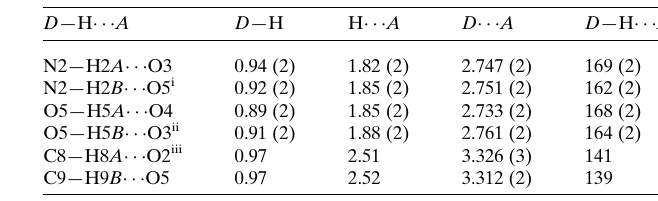
Table 1 Hydrogen-bond geometry (A˚ , (cid:5) ).